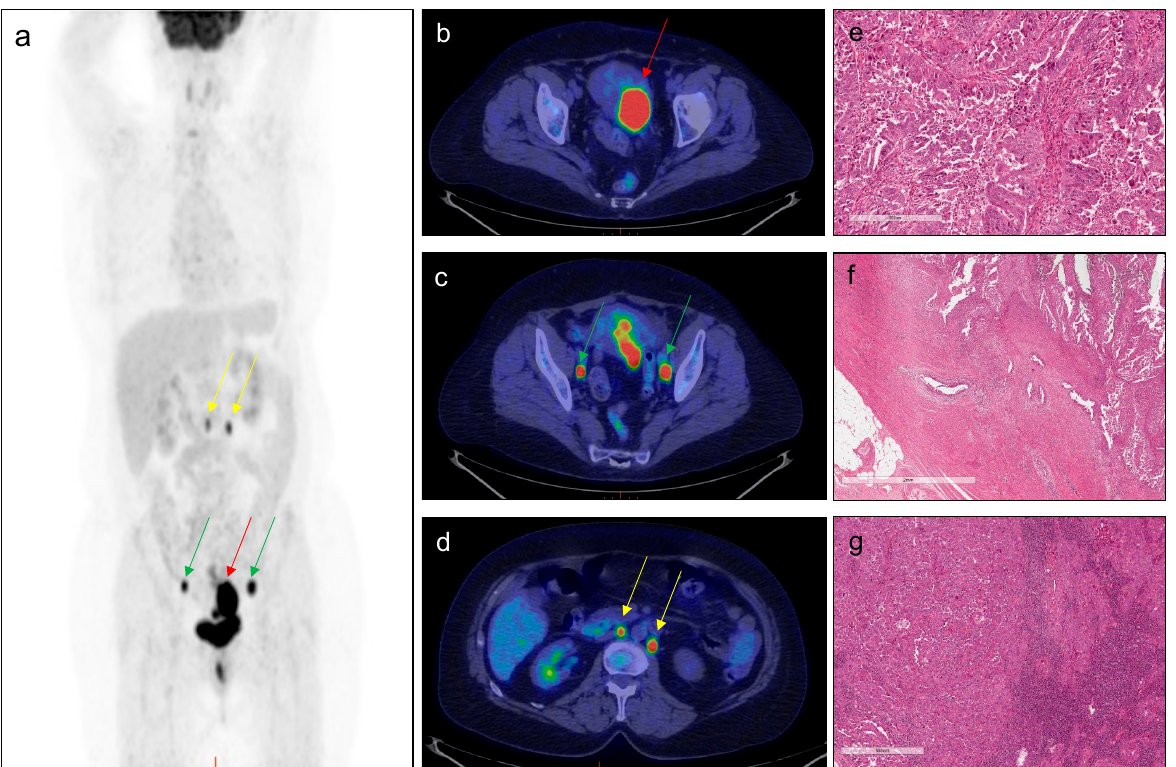
Figure 3. 18 F–FDG PET performed for EC staging . A 71–year–old patient with endometrial cancer (Stage: III C1; Grade: 3; histotype: non–endometrioid EC; MI: 85%; risk group: high–intermediate/ high; presence of LNs) who underwent 18 F–FDG PET/CT for staging purpose. Red arrows indicate pathological uptake in correspondence of the primary tumour. green arrows indicate pathological uptake in correspondence of bilateral iliac–obturator lymph nodes and yellow arrows indicate pathological uptake in correspondence of lomboaortic and interaortocaval lymph nodes (( a ): MIP; ( b ). ( c ) and ( d ): transaxial PET/CT images). PET parameters of the primary tumour were as follow: